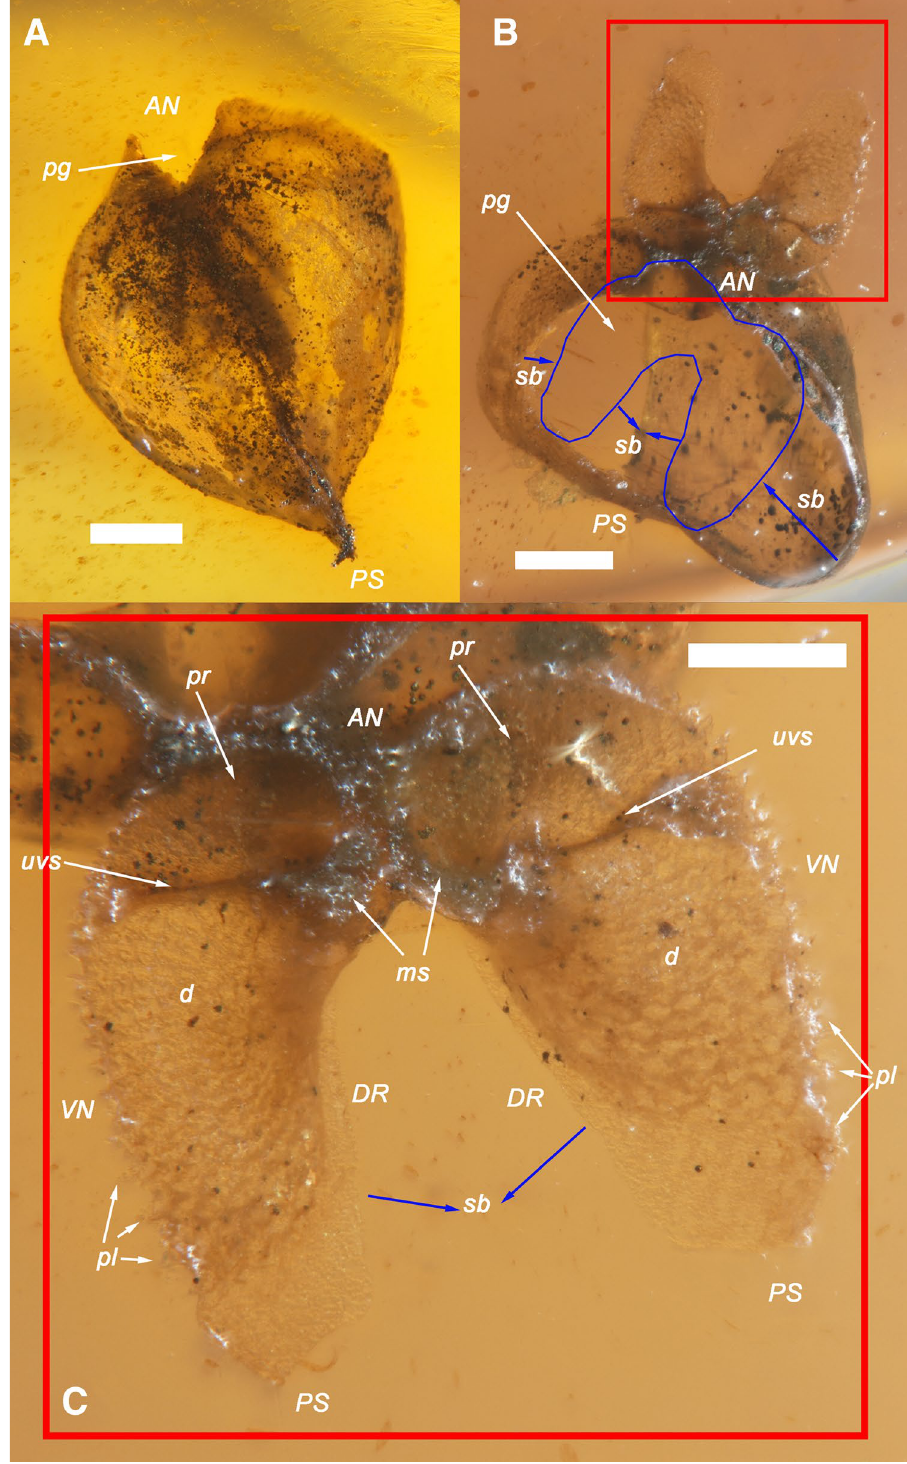
Figure 4. Paratypes of † Palaeolignopholas kachinensis gen. & sp. nov. from lower Cenomanian Kachin amber, northern Myanmar. ( A ) Paratype: dorsal view of articulated shell. Scale bar = 500 µm. ( B ) Paratype: dorsal view of articulated shell. The detached and deflected umbonal paired fragment of the valves is framed by red square. The blue contour indicates the lifetime position of this fragment. The blue arrows show the shell breakages. Scale bar = 200 µm. ( C ) Umbonal paired fragment of the holotype valves (inner view). The blue arrows show the shell breakage. Scale bar = 200 µm. VN ventral margin; DR dorsal margin; AN anterior margin; PS posterior margin; ms longitudinally divided mesoplax (inner view); pr prora; d disc; rs rasping surface of the valve; uvs umbonal ventral sulcus; pg pedal gape; pl periostracal lamellae; sb shell breakage. (Photos: Ilya V.